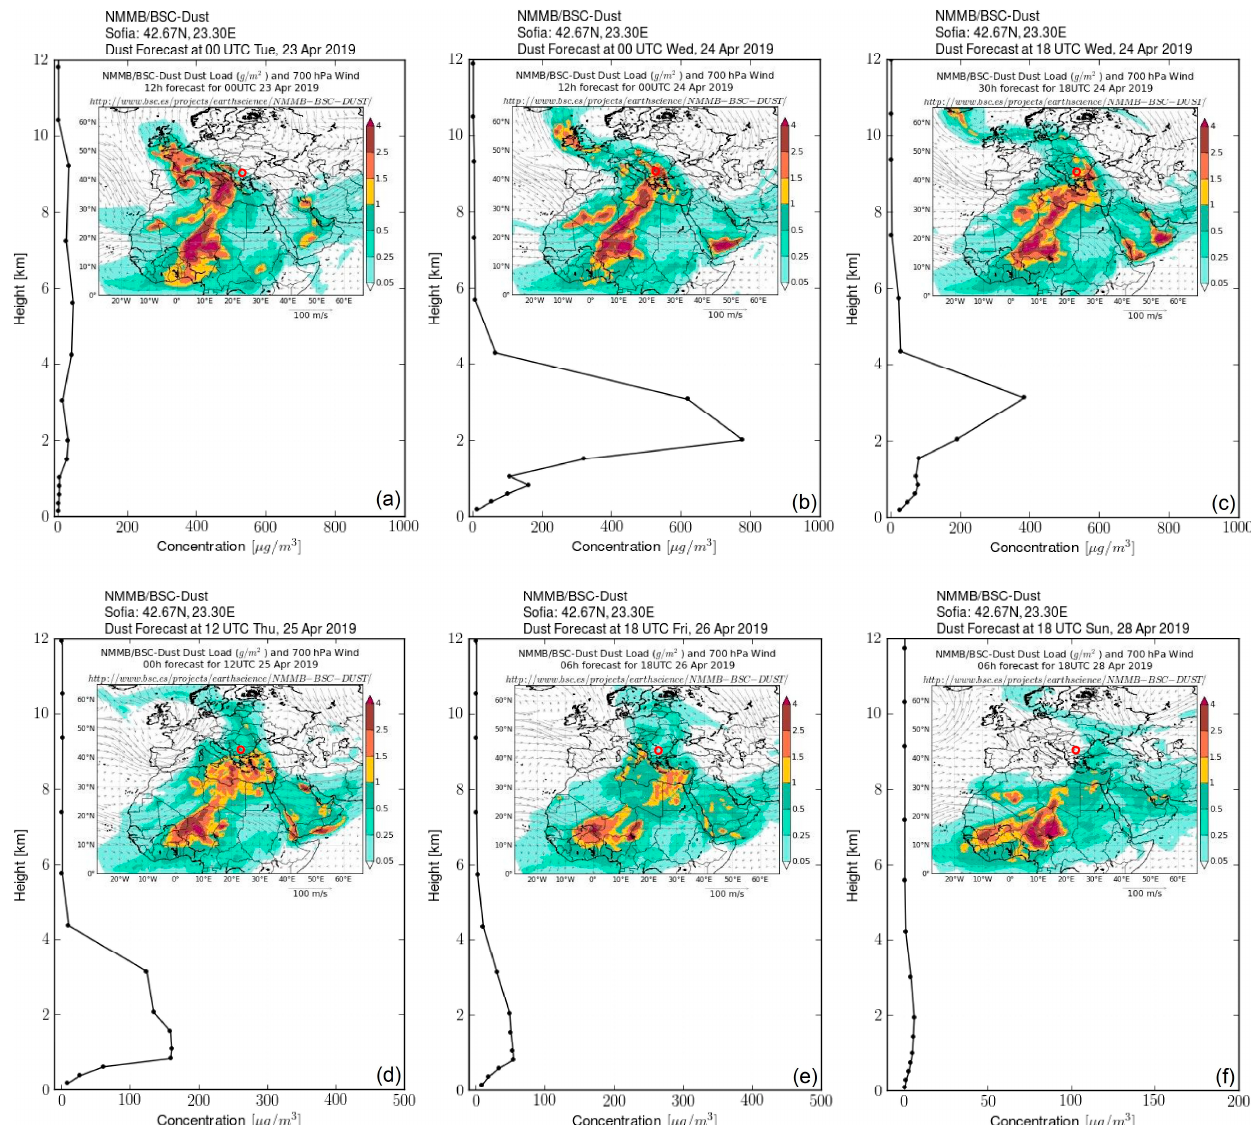
Figure 5. NMMB/BSC-Dust forecast Saharan dust concentration profiles above Sofia and regional maps (insets) of dust load and the 700 hPa wind field, for the period 22–28 April 2019. Sofia position is indicated by a red circle.